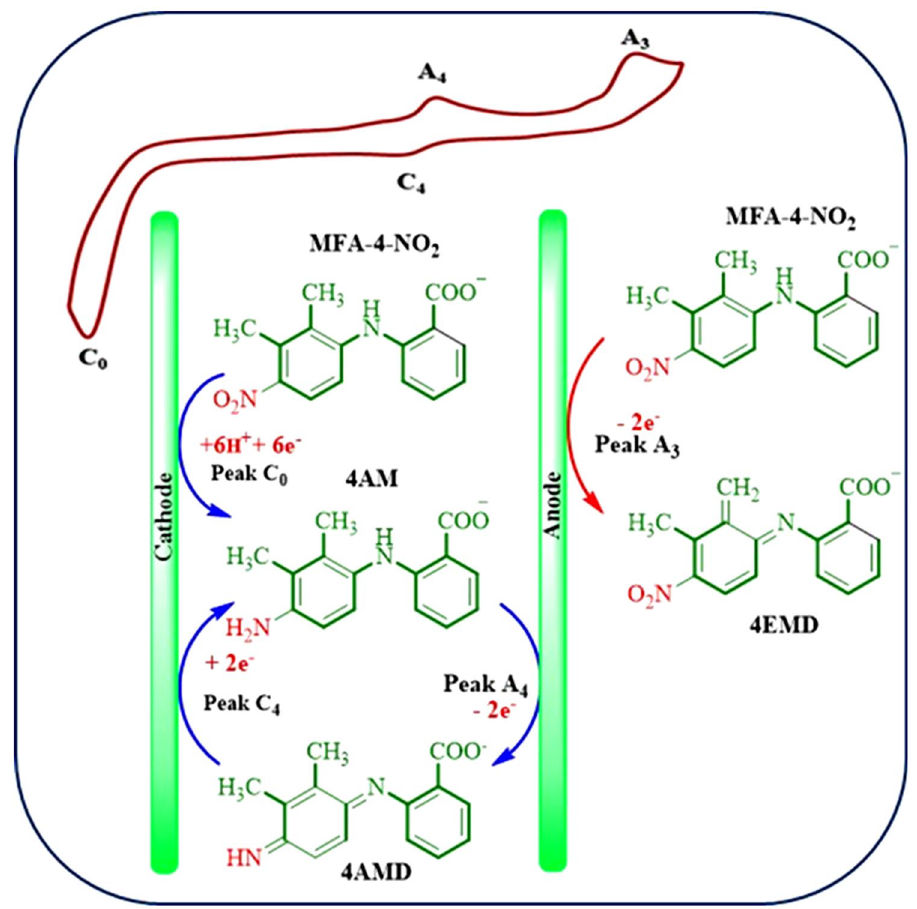
Figure 17. The proposed mechanism for oxidation–reduction of nitromefenamic acid.